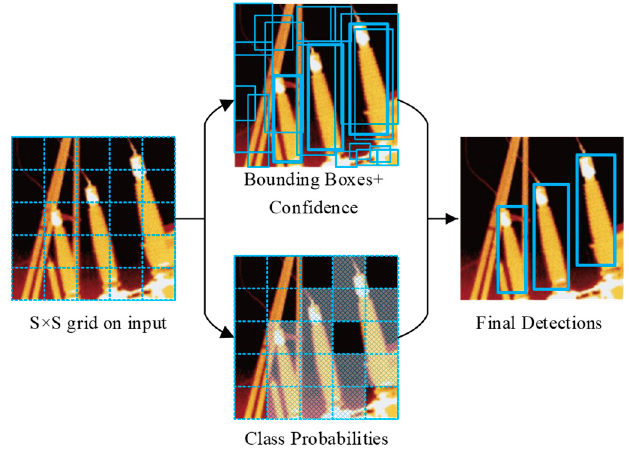
Figure 1. You Only Look Once version 2 (YOLOv2) network target detection process diagram.